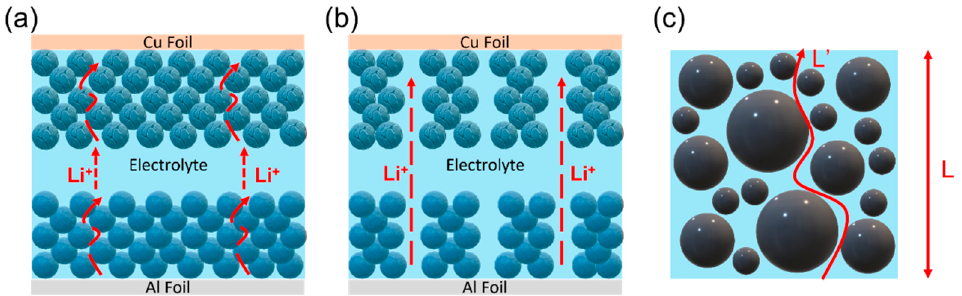
Figure 1. Schematic drawing illustrating lithium-ion diffusion in ( a ) the high-tortuous electrode and ( b ) the low-tortuous electrode. ( c ) Sketch of the length (L’) of a tortuous path in a porous electrode with a certain thickness (L).